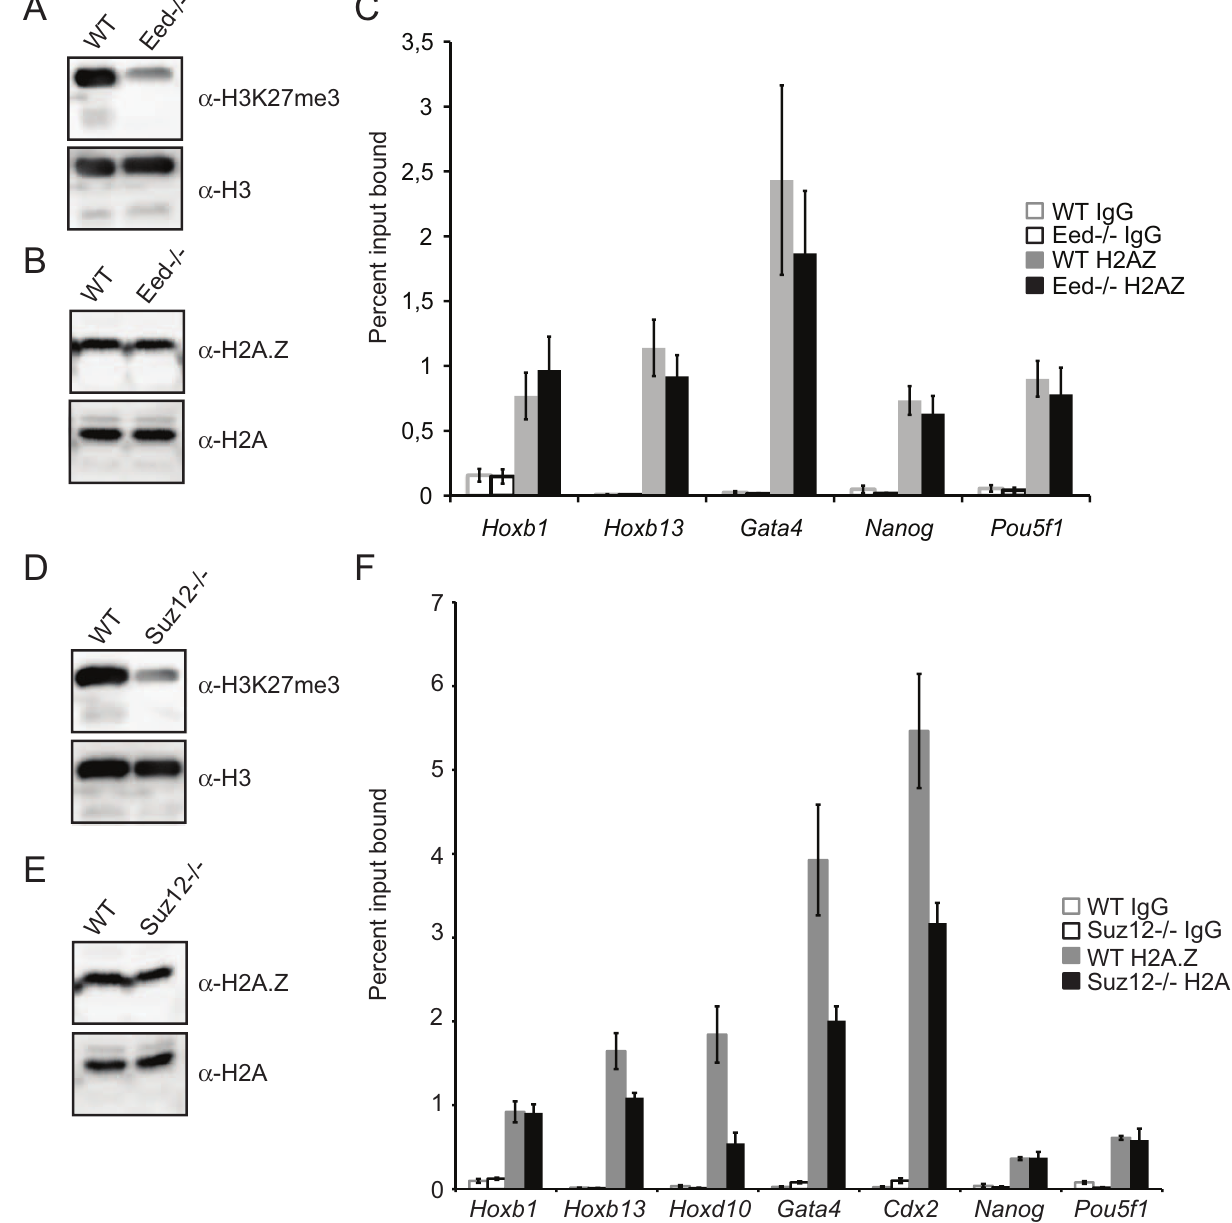
Figure 5. H2A.Z enrichment is not dependent on PRC2. A) Immunoblots for H3K27me3 and H3 in Eed 2 / 2 and matched WT ESCs B) Immunoblots for H2A.Z and H2A in Eed 2 / 2 and matched WT ESCs. C) ChIP for control IgG or H2A.Z at the promoters of Hoxb1, Hoxb13, Gata4, Pou5f1 and Nanog, assayed by qRT-PCR, in WT (grey) or Eed 2 / 2 (black) ESCs. Enrichment is shown as mean % input bound 6 s.e.m. over three biological replicates. IgG is shown in white bars. D) Immunoblots for H3K27me3 and H3 in Suz12 2 / 2 and WT ( Eed + / + ) ESCs E) Immunoblots for H2A.Z and H2A in Suz12 2 / 2 and WT ( Eed + / + ) ESCs. F) ChIP for control IgG or H2A.Z at the promoters of Hoxb1, Hoxb13, Hoxd10, Gata4, Cdx2, Pou5f1 and Nanog, assayed by qRT-PCR, in WT (grey) or Suz12 2 / 2 (black) ESCs. Enrichment is shown as mean % input bound 6 s.e.m. over three biological replicates. IgG is shown in white bars.